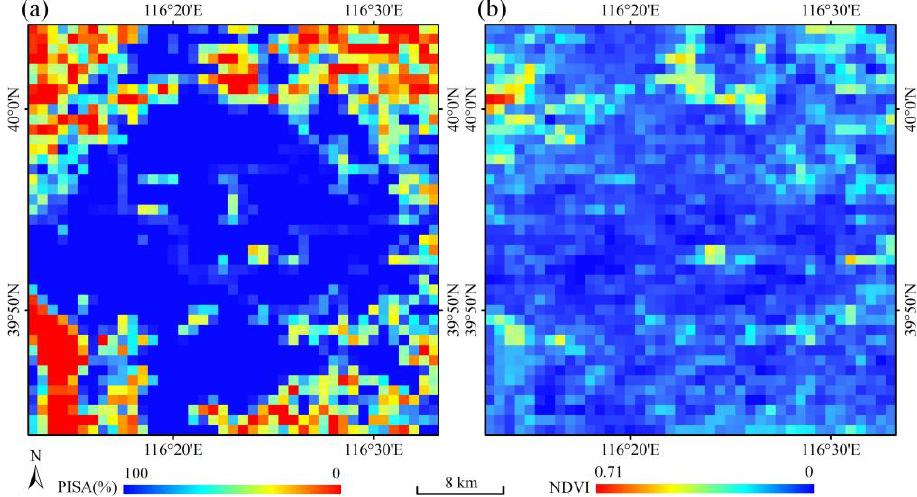
Figure 3. A comparison of spatial distributions using ( a ) percent impervious surface area (PISA) and ( b ) normalized difference vegetation index (NDVI) over the urbanized areas in Beijing.